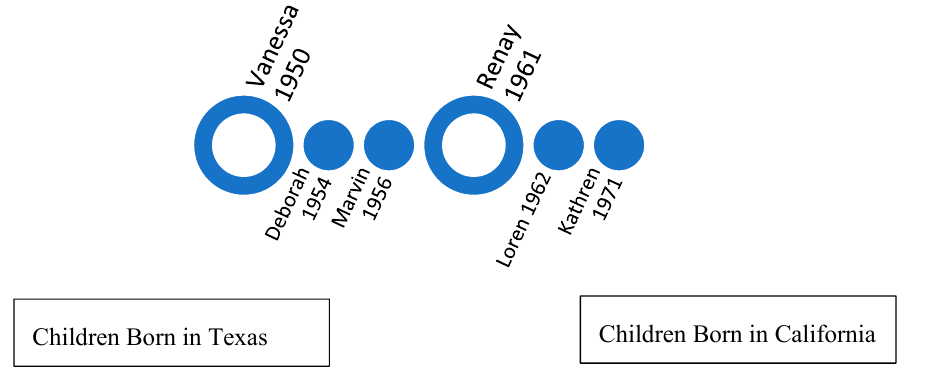
Figure 1. This is a figure of a timeline demonstrating the years and State of my grandmother’s children’s births.